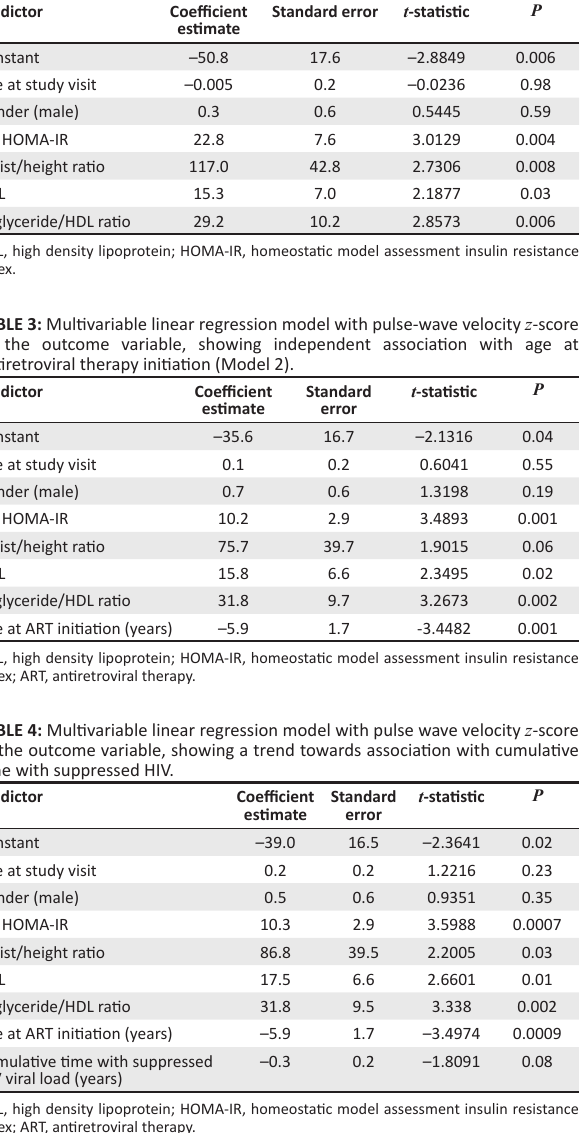
the outcome variable, optimised for metabolic syndrome components (Model 1). Predictor Coefficient estimate